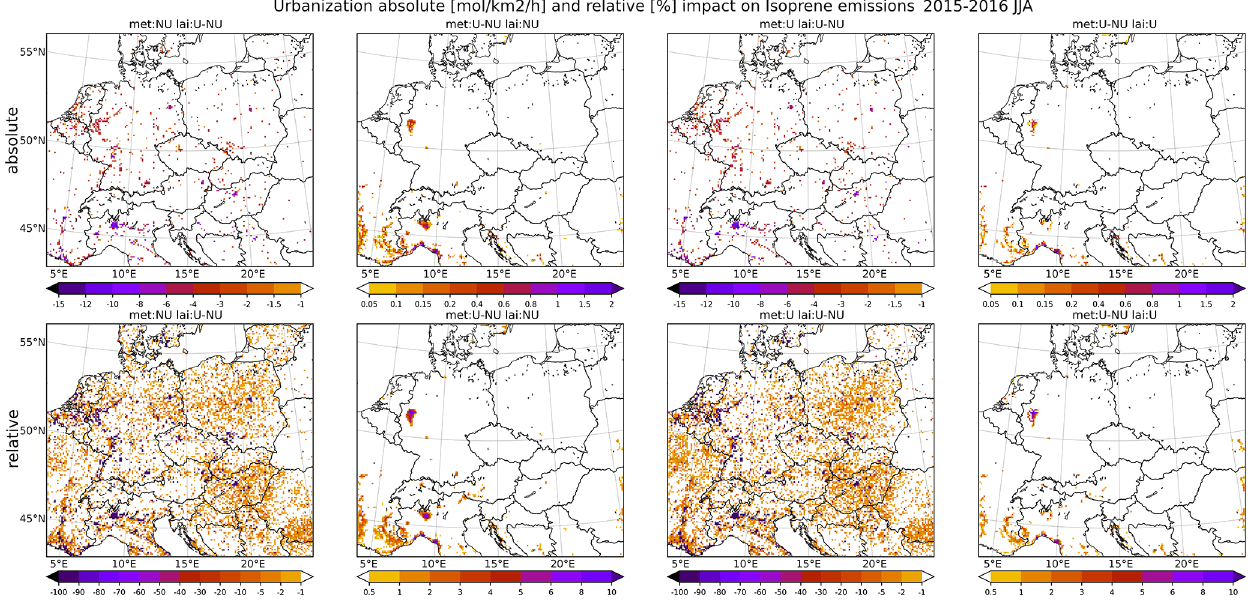
Figure 9. The absolute (upper row; units molkm − 2 h − 1 ) and relative change (lower row; units in %) in 2015–2016 JJA averaged isoprene (ISOP) emissions decomposed into the part caused by reduced vegetation (via leaf area index; DBVOC_L) and the part caused by modified meteorology (DBVOC_M). The first and third columns show the change due to DBVOC_L taking the rural (NU) and urban (U) meteorolog- ical conditions as a reference, respectively. In the second and fourth columns, the changes due to urban meteorological effects (UCMF) are shown (DBVOC_M) taking the rural (NU) and urban (U) vegetation as a reference,